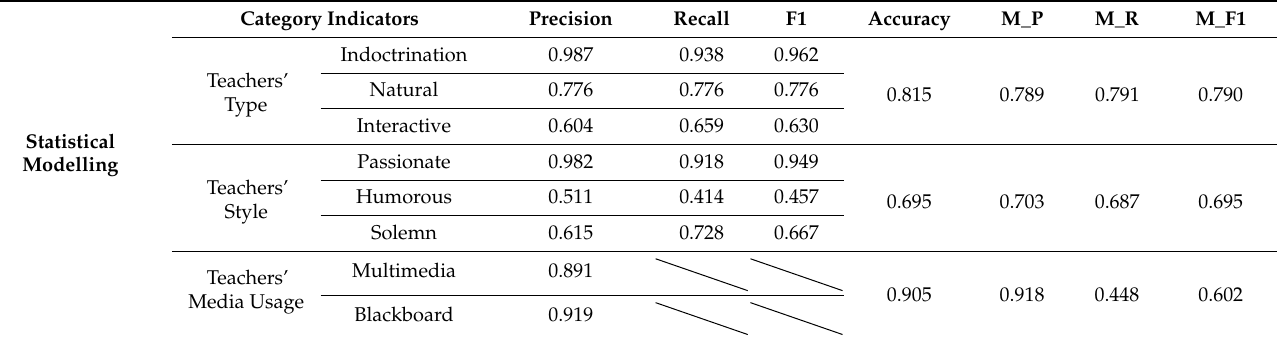
Table 8. Performance analysis for category indicators evaluated by the statistical modeling module.